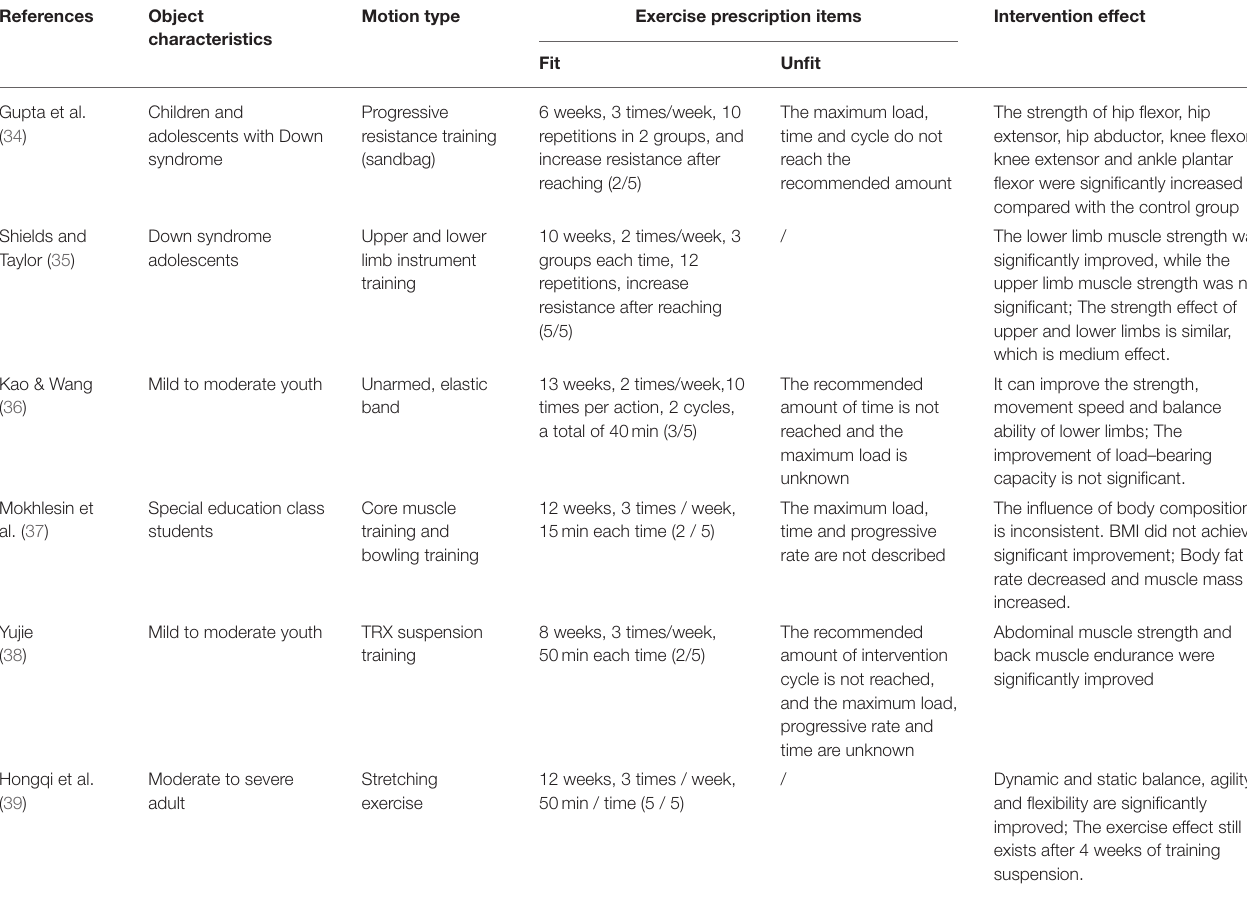
TABLE 3 | Effects of an exercise intervention on muscle strength, muscle endurance, and flexibility of people with intellectual